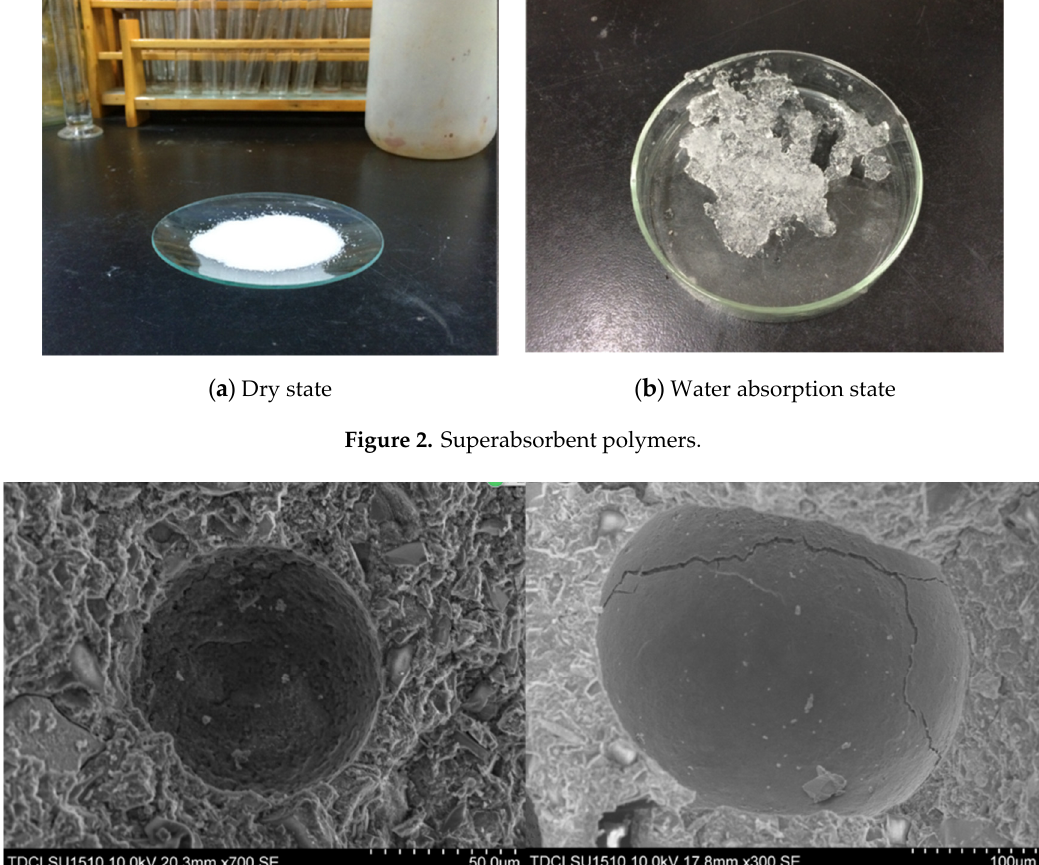
Figure 2. Superabsorbent polymers.